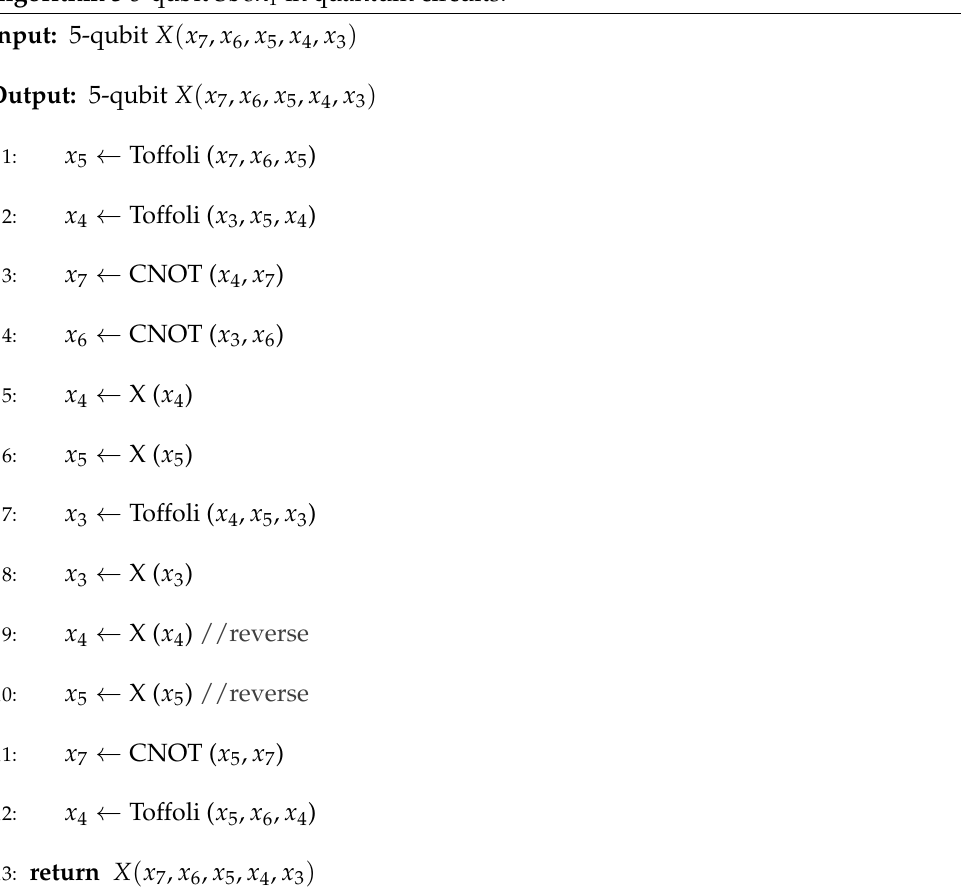
Algorithm 3 5-qubit Sbox 1 in quantum